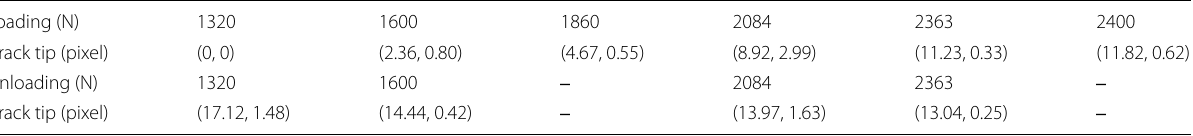
Table 10 Relative coordinates of crack